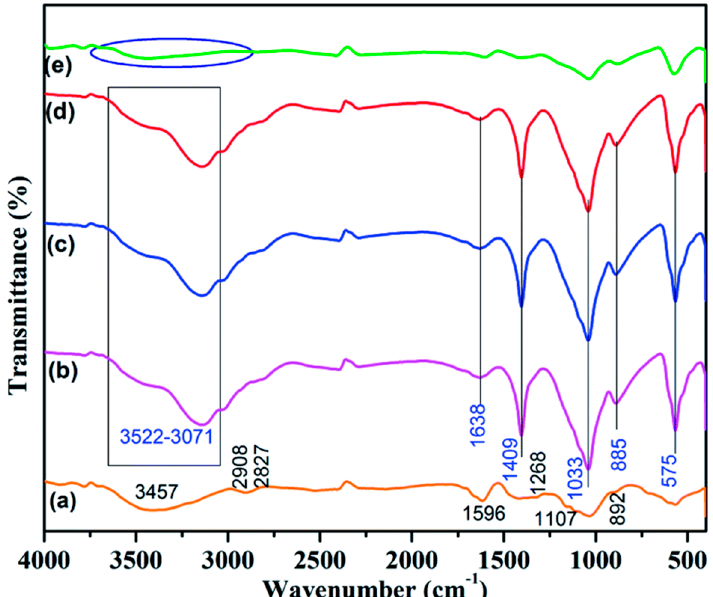
Figure 20. FTIR spectrum of ( a ) chitosan (CS), ( b ) aluminum bentonite clay-malic acid chitosan